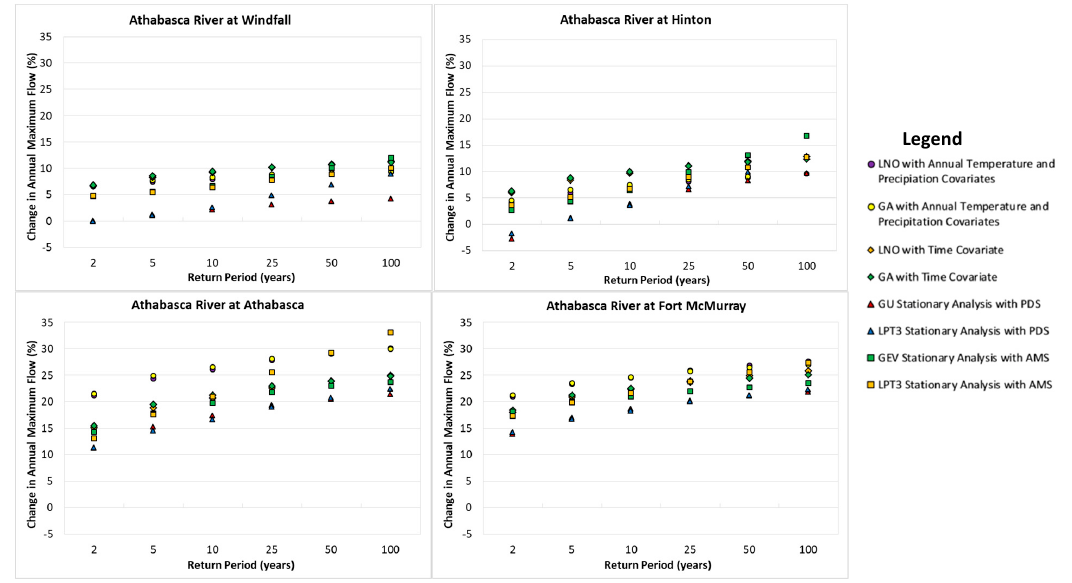
Figure 9. Ensemble mean projected changes (%) in the magnitude of flood events of different return periods between the 2080s and the 1990s baseline period for the RCP8.5 emissions scenario corresponding to both stationary and non-stationary methods of extreme flow analysis.